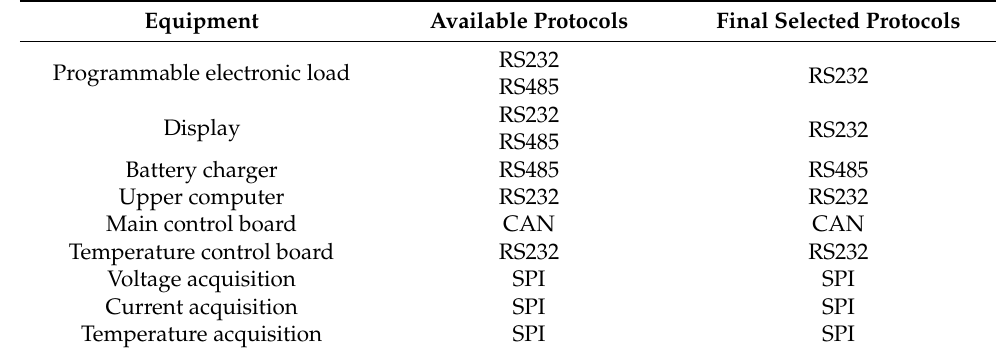
Figure 9. The energy information flow of the verification platform. Table 2. Verification platform communication protocols